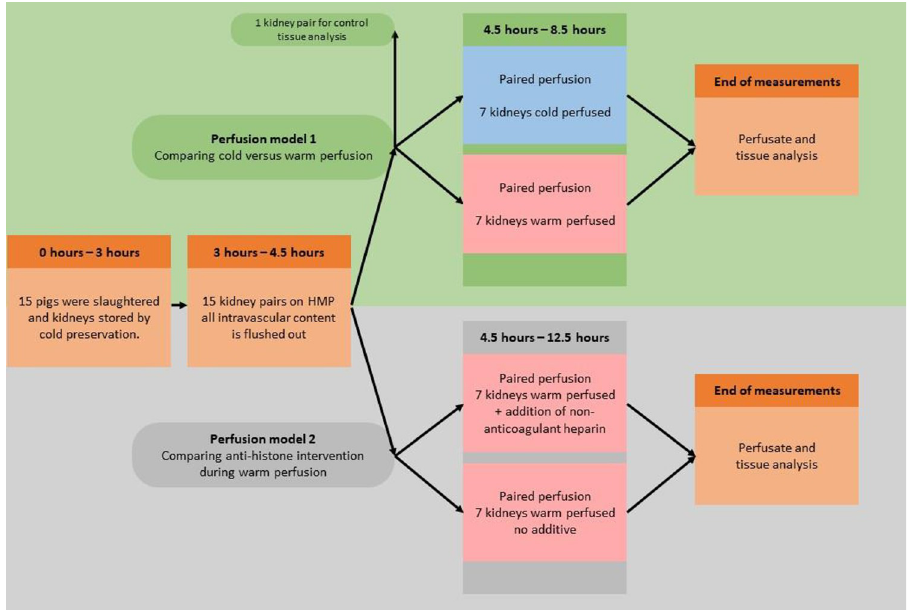
Fig 1. Paired ischemic porcine kidney perfusion models. Porcine kidneys are retrieved from the slaughterhouse and flushed 25min after sacrifice (warm ischemia time). Kidneys are then put on cold storage for 3h until the first period of cold machine perfusion at 4˚C. Subsequently, kidneys are flushed one more time before being assigned to their group. Model 1 (green) includes 2 groups; 4h of cold perfusion vs 4h of warm perfusion. Regular perfusate sampling is done during this final perfusion period and at the end, biopsies are taken for further analysis. Model 2 (gray) includes 2 groups of warm perfusion; one kidney from a pair received non-anticoagulant heparin (0.31 mg/mL or 54 U/mL), whilst the other did not receive treatment. A total of 7 kidney pairs were used, from which 3 were perfused up to 4h and the other 4 pairs were perfused up to 8h. Regular perfusate sampling was done and tissue was collected at the end of